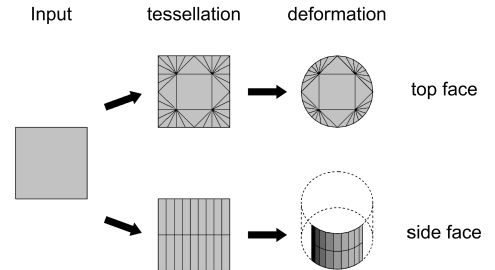
Figure 8: Patch tessellation: Top and side faces are tessellated differently since they need to undergo different